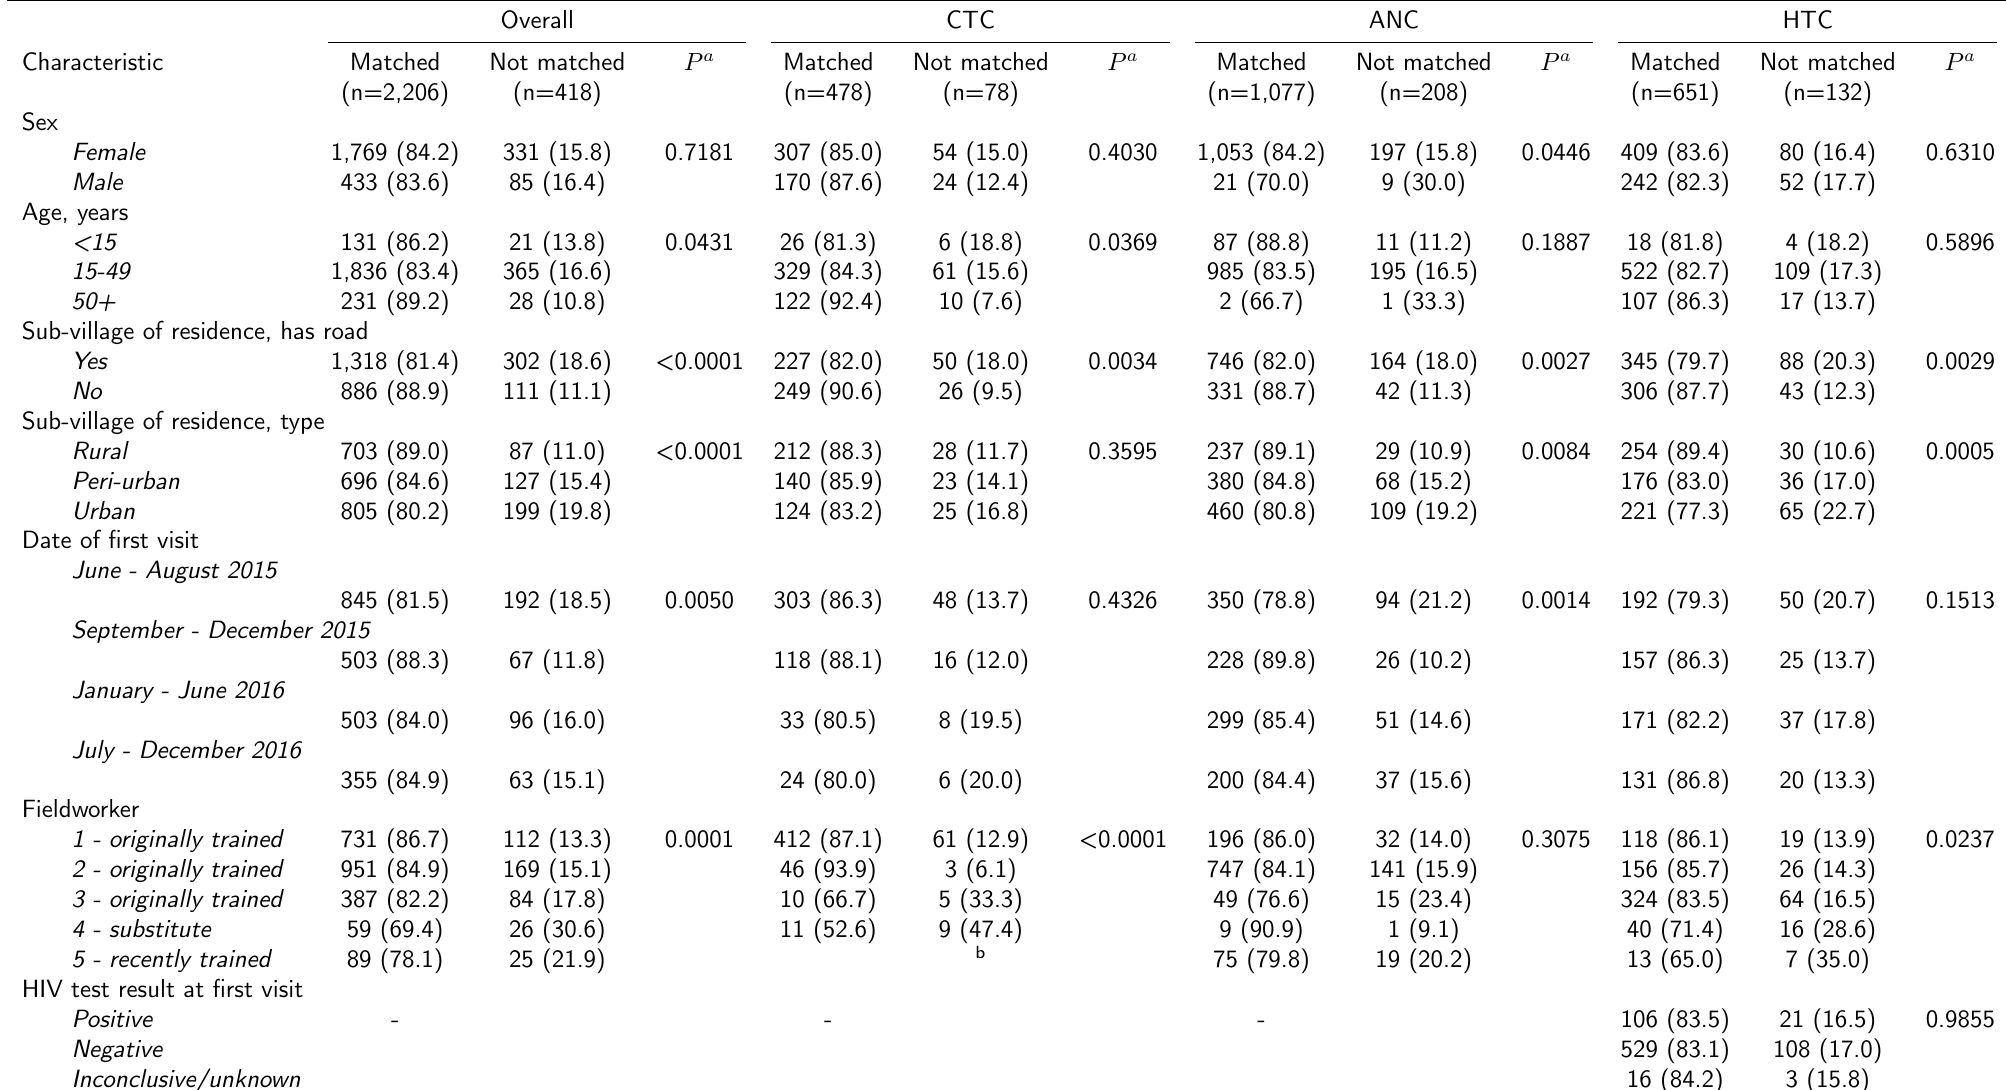
Table 2: Match percentages among eligible point-of-contact interactive record linkage (PIRL) participants in rural Tanzania, by patient characteristic and clinic, n=2,624 Overall CTC ANC